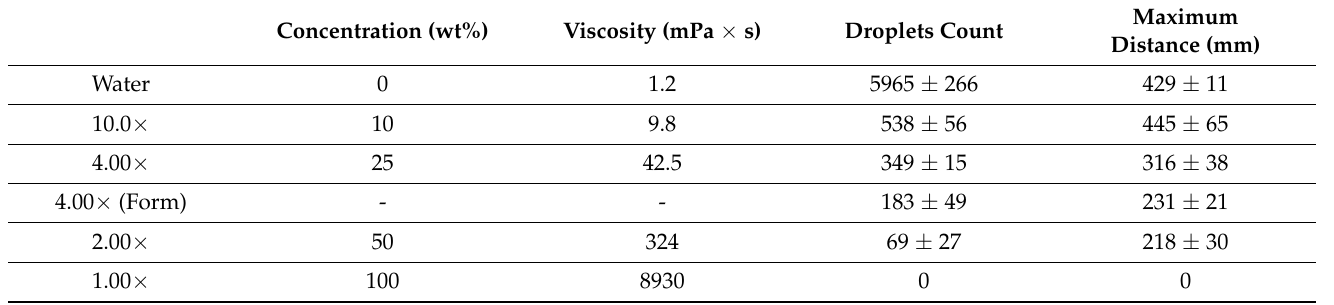
Table 1. Comparison of viscosity, droplet amount, and maximum droplet distance by toothpaste dilution